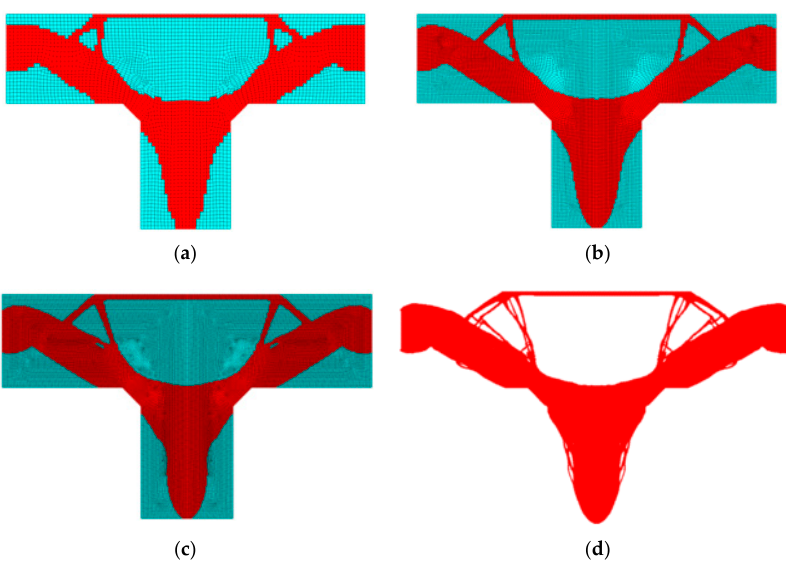
Figure 25. The final topologies for 1830 ( a ), 7180 ( b ), 15,359 ( c ), and 130,896 ( d ) elements. In the last